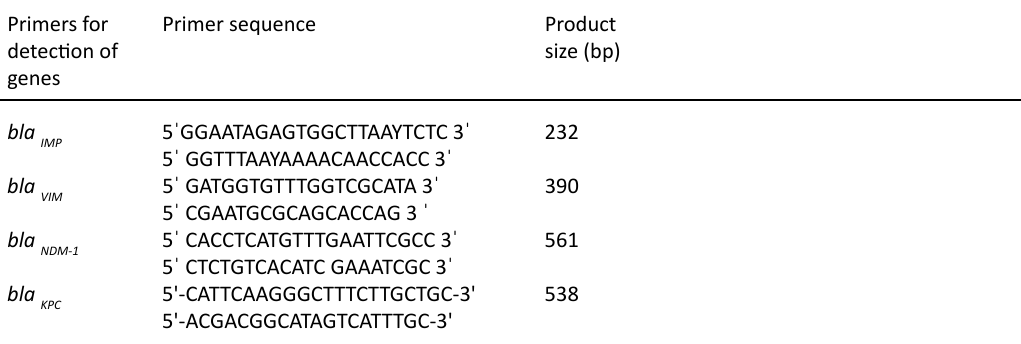
Table 1. The primer sets were in PCR reaction